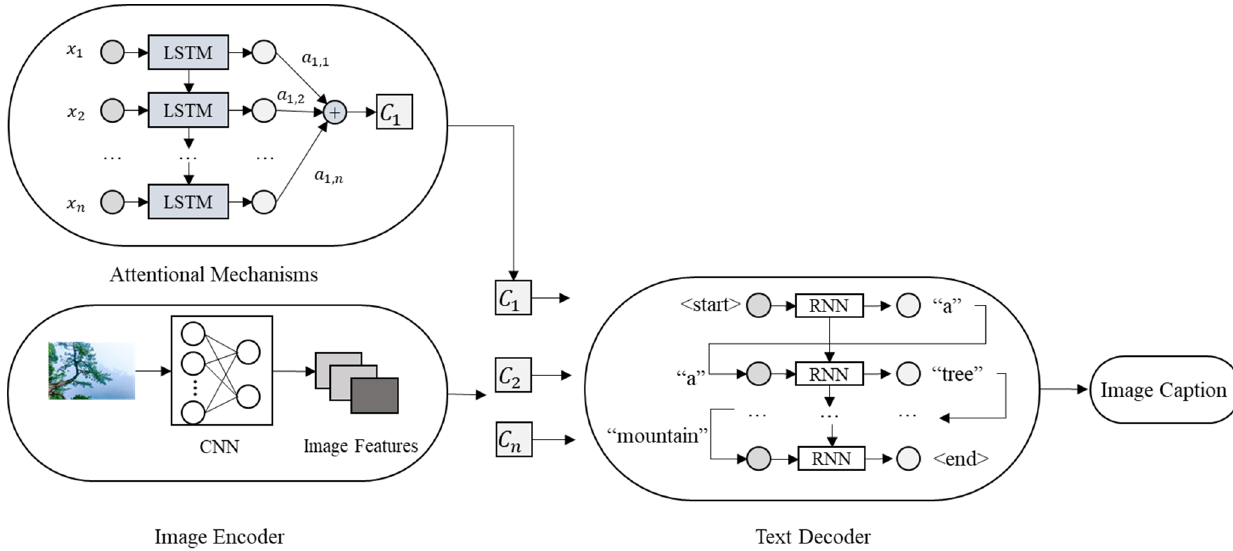
Figure 3. Encoder-decoder framework with attention mechanism.